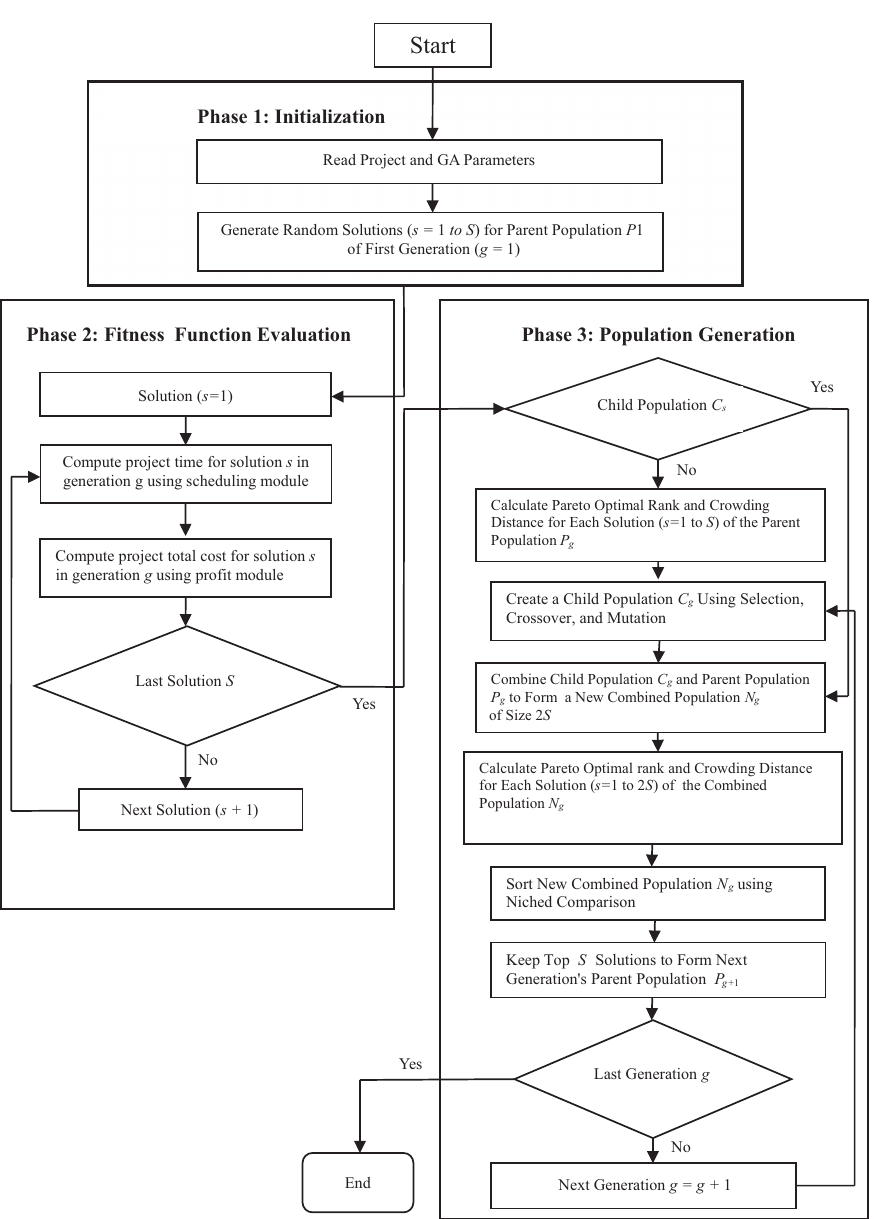
Fig. 1. Multi-objective genetic algorithm